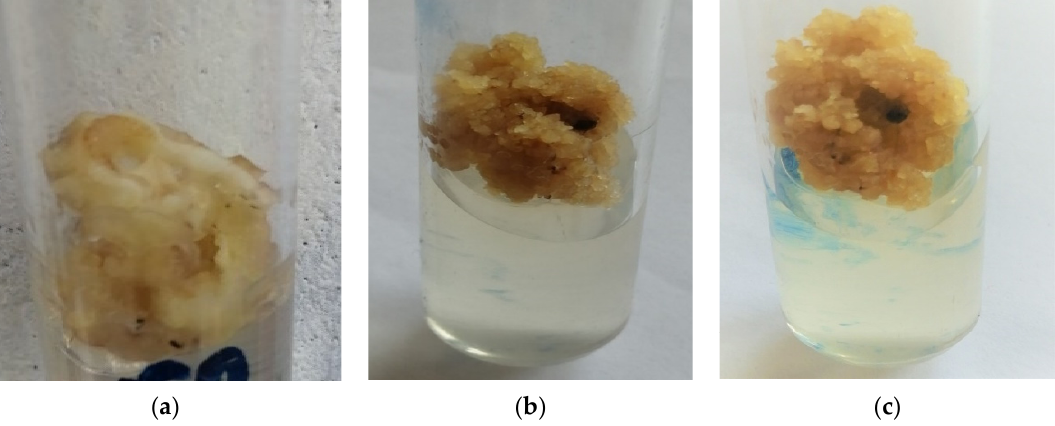
Figure 2. Callus of YT-53 on MS +3 mgL − 1 2,4-D + 0.5 mgL − 1 Kinetin after 10 ( a ), 20 ( b ), and 30 ( c ) days of inoculation (2×).